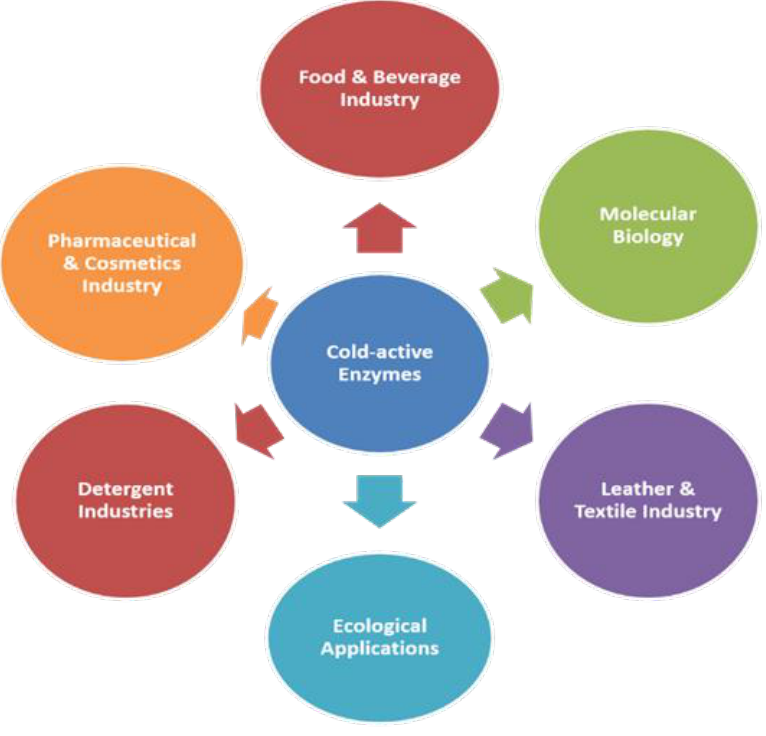
Figure 2. Application areas of cold-active enzymes (CAEs).